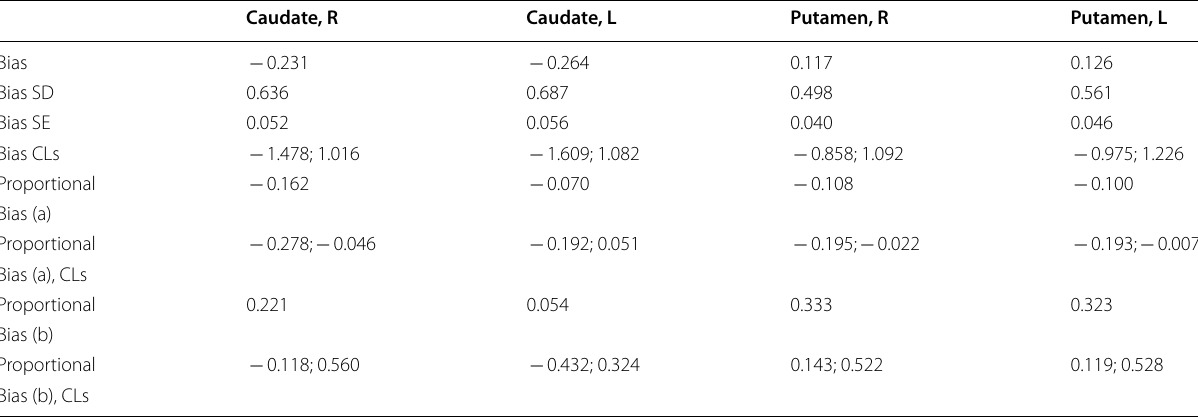
(a) and (b) values of (a) and (b) of fitting equation; Y = SD, standard deviation; SE, standard error; CL, confidence limits, L, left; R,